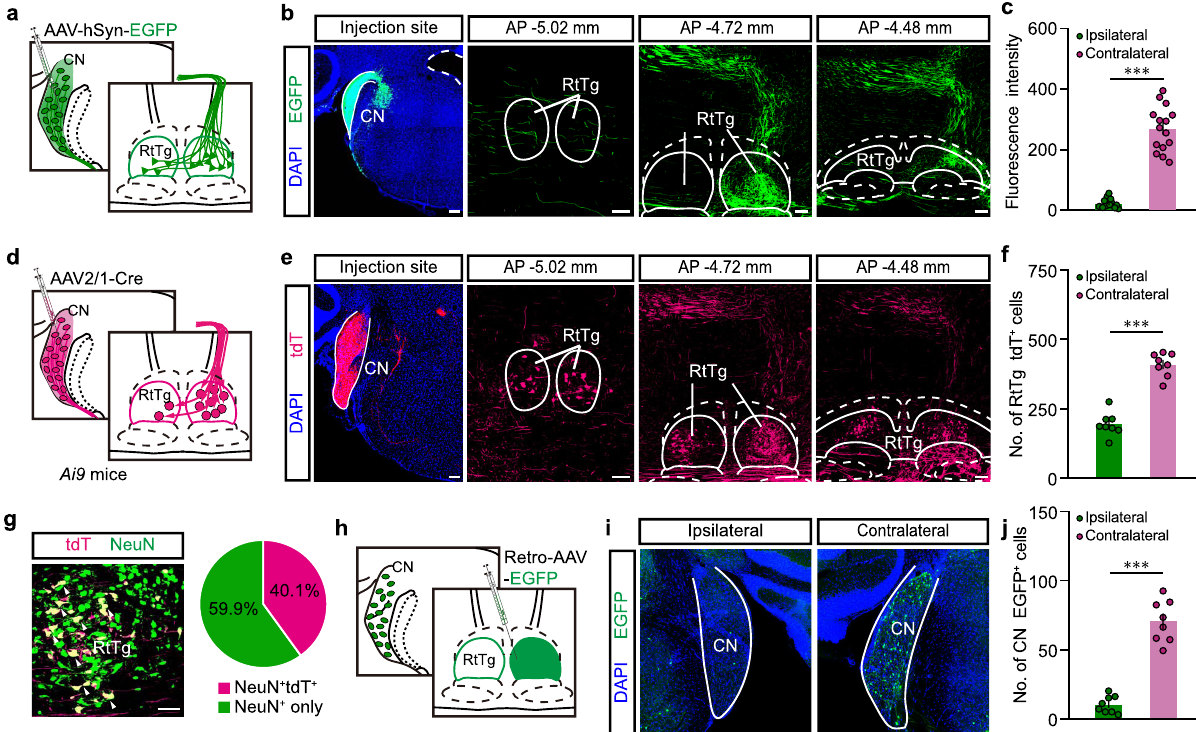
Fig. 4 Identi fi cation of a CN-RtTg direct projection. a Schematic for the anterograde tracing from CN to RtTg. b Representative images showing CN injection site and EGFP + presynaptic terminals in RtTg. Scale bar, 200 μ m. c Quantitative fl uorescence intensity of CN EGFP + presynaptic terminals in the ipsilateral and contralateral RtTg ( n = 15; P = 8.87×10 − 9 ). d Schematic for the anterograde transsynaptic tracing from CN to RtTg. e Representative images showing CN injection site and the tdT + cells in RtTg. Scale bar, 200 μ m. f Quanti fi cation of tdT + cell numbers in the ipsilateral and contralateral RtTg ( n = 8; P = 3.8×10 − 7 ). g Left: a representative image showing tdT + RtTg neurons co-labelled with NeuN (white arrowheads). Scale bar, 50 μ m. Right: pie chart indicating the percentage of NeuN + neurons co-labelled with or without tdT. h Schematic for the retrograde tracing from RtTg to CN. i Representative images showing EGFP + neurons in ipsilateral and contralateral CN. Scale bar, 200 μ m. j Quanti fi cation of EGFP + cells number in the ipsilateral and contralateral CN ( n = 8; P = 5.09×10 − 6 ). Error bar represents mean ±s.e.m. Signi fi cance was assessed using two-sided paired t- tests in c , f , j . *** P